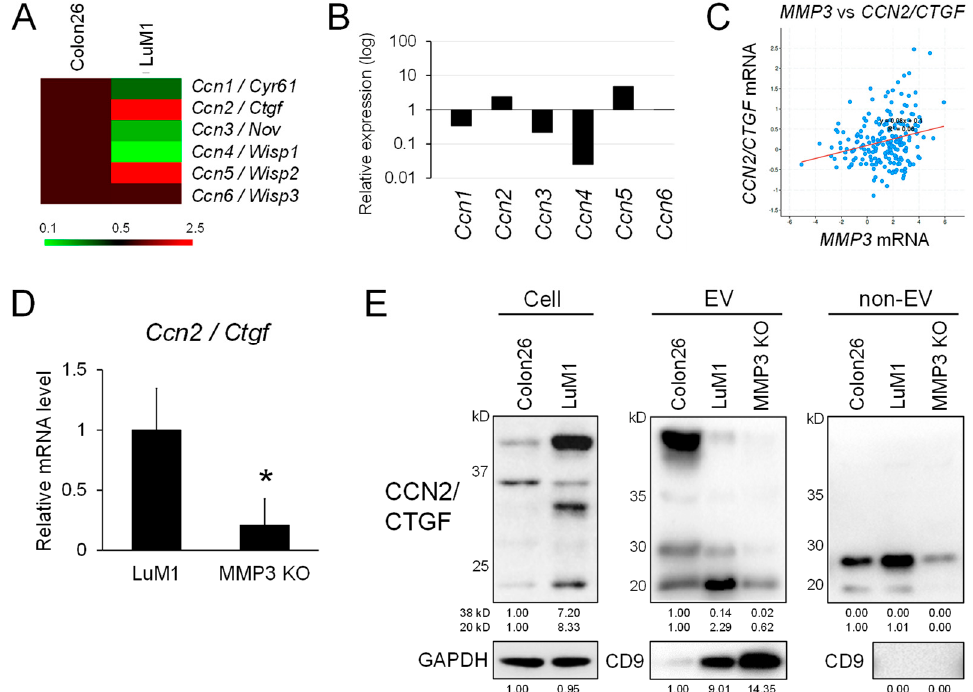
Figure 5. MMP3 knockout diminished gene expression and C-terminal fragments of CCN2 / CTGF. ( A – C ) The positive correlation between MMP3 and CCN2 / CTGF expression. ( A ) Heatmap analysis of the CCN gene family members between LuM1 vs. Colon26 cells. The data are from microarray analysis. ( B ) Relative mRNA expression levels of CCN gene family members in LuM1 vs. Colon26 cells. ( C ) Scatter plot analysis showing co-expression correlation between MMP3 vs. CCN2 / CTGF in patients-derived tumor samples of colorectal adenocarcinomas (632 cases). ( D ) RT-qPCR analysis of Ccn2 / Ctgf transcripts expressed in LuM1 vs. MMP3-KO cells. n = 6, * p < 0.05. ( E ) Western blot analysis of CCN2 / CTGF fragments in cellular, EV and non-EV fractions. C-terminal TSP1-CT fragments (20–25 kD) of CCN2 / CTGF were at di ff erent levels among extracellular fractions of Colon26, LuM1, and MMP3-KO cells. CD9, a category-1 EV marker. GAPDH, loading control. The experiments were repeated twice in Figure